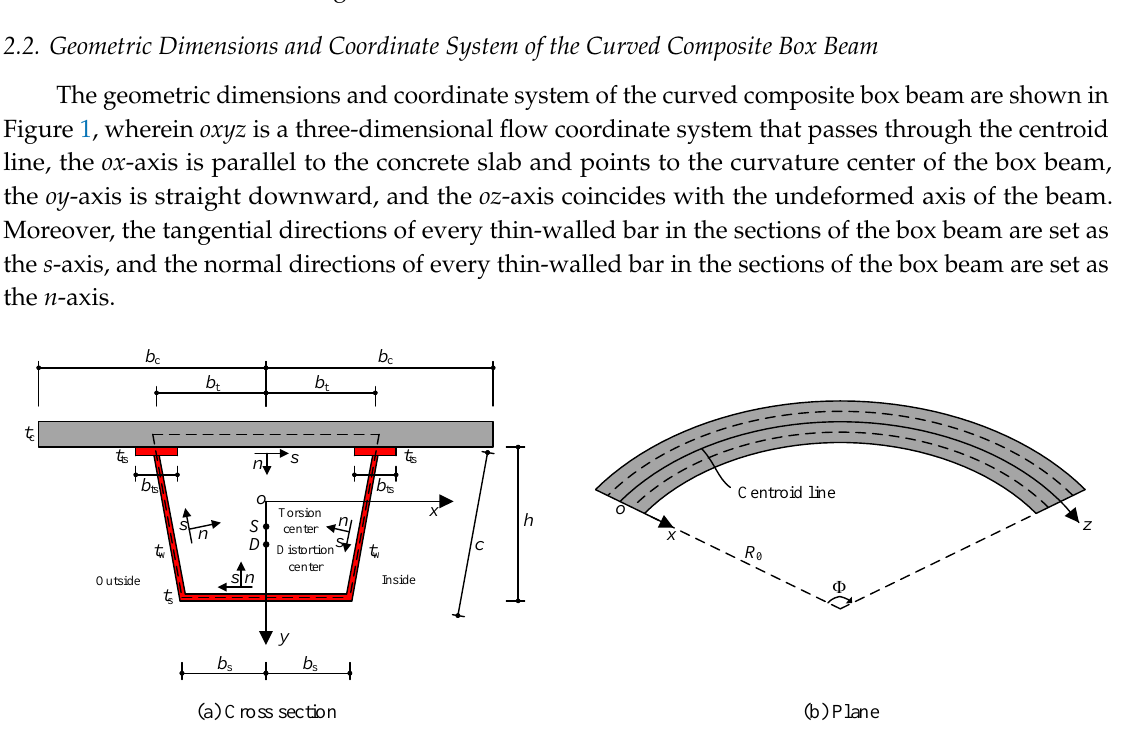
Figure 1. Geometric dimensions and coordinate system of the curved composite box beam: ( a ) cross section, ( b ) plane.